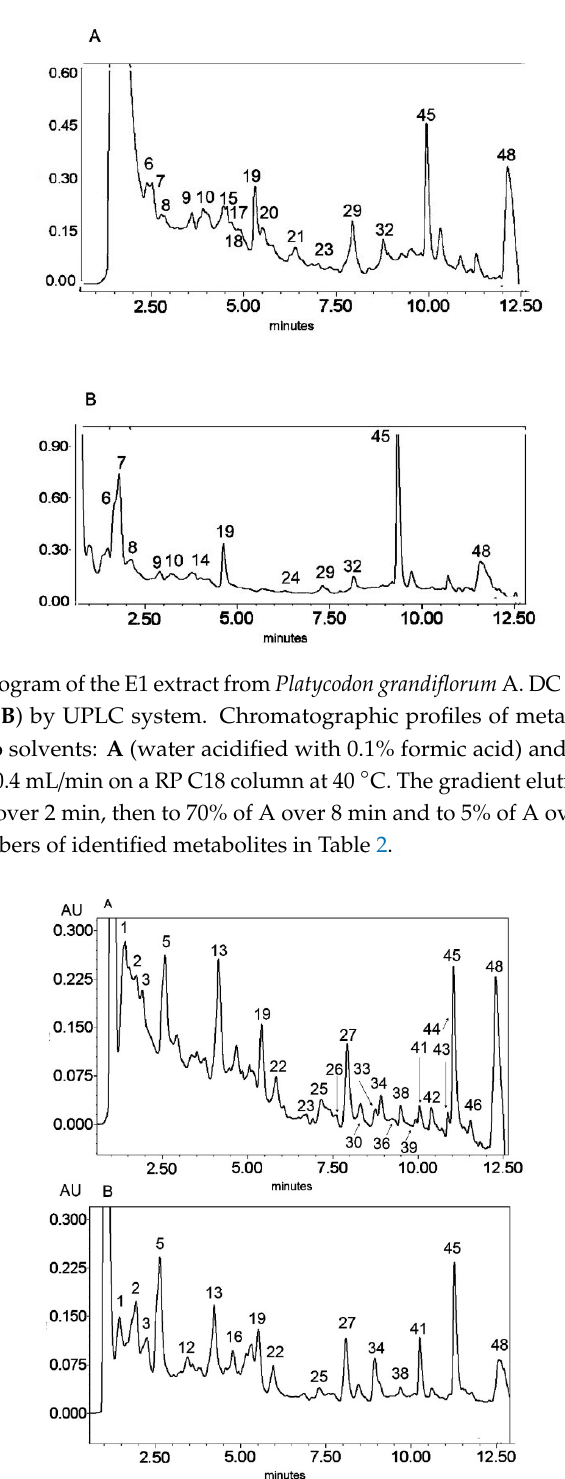
Figure 2. UV chromatogram of the E2 extract from Platycodon grandiflorum A. DC recorded at λ = 230 nm ( A ) and λ = 280 nm ( B ) by UPLC system. Chromatographic profiles of metabolites were obtained with gradients of two solvents: A (water acidified with 0.1% formic acid) and B (100% acetonitrile), mobile phase flow of 0.4 mL/min on a RP C18 column at 40 °C. The gradient elution: 100% of A linearly changed to 80% of A over 2 min, then to 70% of A over 8 min and to 5% of A over 1 min. The number corresponded to numbers of identified metabolites in Table